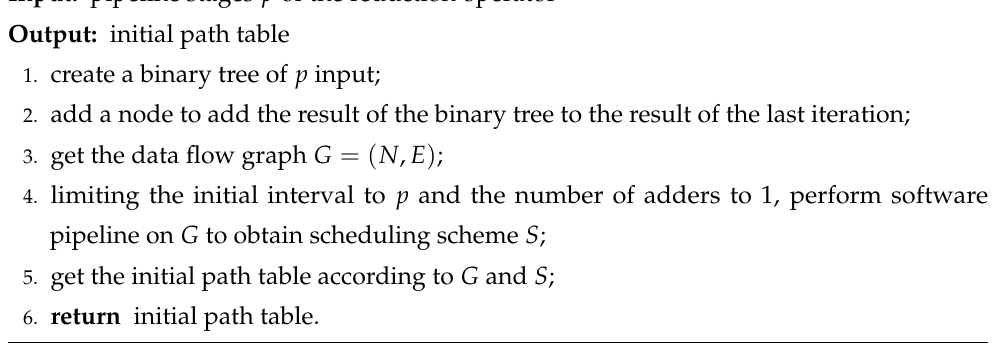
Algorithm 1 BTPP Part 1: Binary tree path initialization